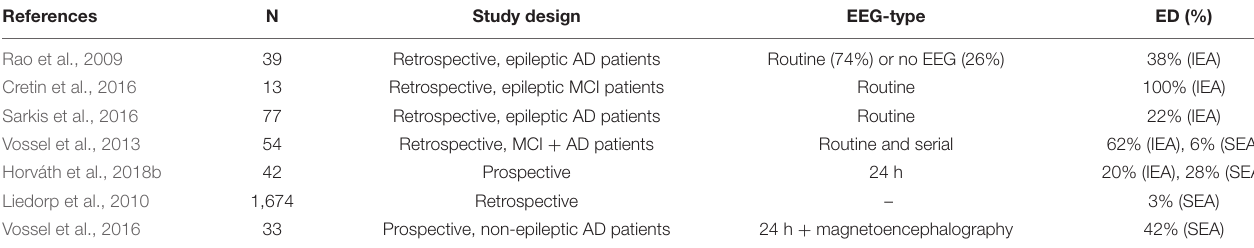
TABLE 1 | Prevalence of epileptiform discharges in Alzheimer’s